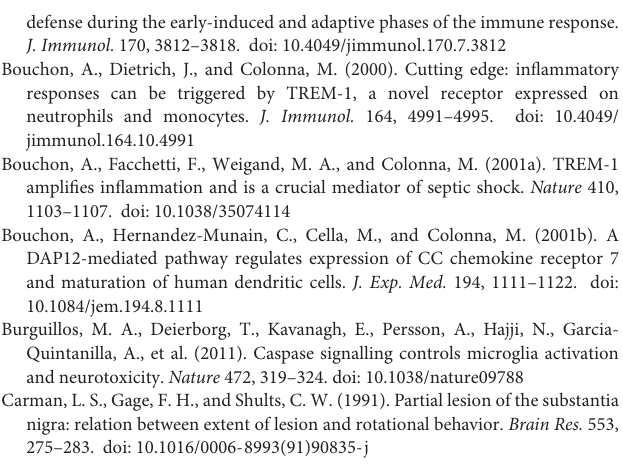
FIGURE S1 | Uncropped Western blots of Figure 1A : TREM-1 and Figure 1B : β -actin. FIGURE S2 | Uncropped Western blots of Figure 2A : iNOS, COX-2, and β -actin. FIGURE S3 | Uncropped Western blots of Figure 2B : I κ B, β -actin, NF- κ B, and Lamin B. FIGURE S4 | Uncropped Western blots of Figure 3B : LC3, p-mTOR, HDAC-6, mTOR, and β -actin. FIGURE S5 | Uncropped Western blots of Figure 3C : LC3 and β -actin; Figure 3D : p-ERK, ERK, p-Akt, and Akt. FIGURE S6 | Uncropped Western blots of Figure 4A : TREM-1; Figure 4B : iNOS, COX-2, and I κ B. FIGURE S7 | Uncropped Western blots of Figure 4C : LC3, HDAC6, and β -actin. FIGURE S8 | Uncropped Western blots of Figure 5 : iNOS, COX-2, and β -actin. FIGURE S9 | Uncropped Western blots of Figure 7B : TH, TNF- α , and β